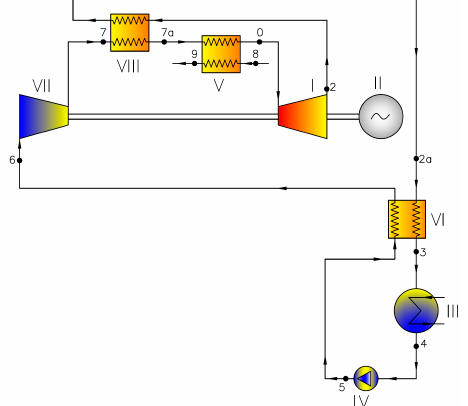
Figure 4. ORC cycle with regenerator, compressor and reheater; where: I—turbine, II—generator, III—condenser, IV—pump, V—vapor generator, VI—regenerator, VII—compressor, VIII—heat exchanger (Variant 6).